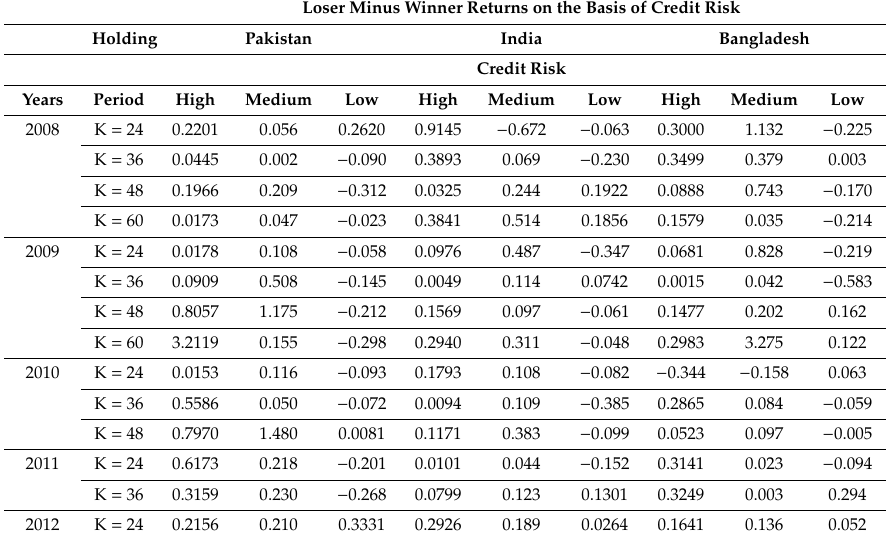
Table 4. Contrarian profitability by credit risk. Loser Minus Winner Returns on the Basis of Credit